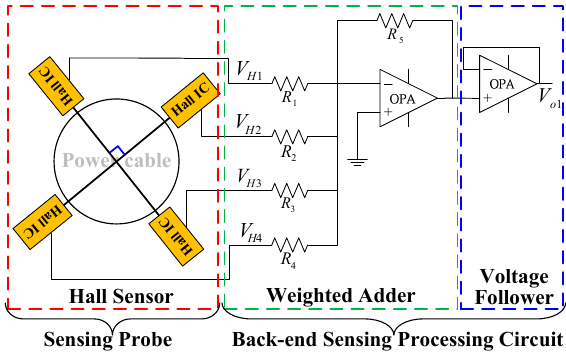
Figure 1. Sensor module for the proposed HCT.